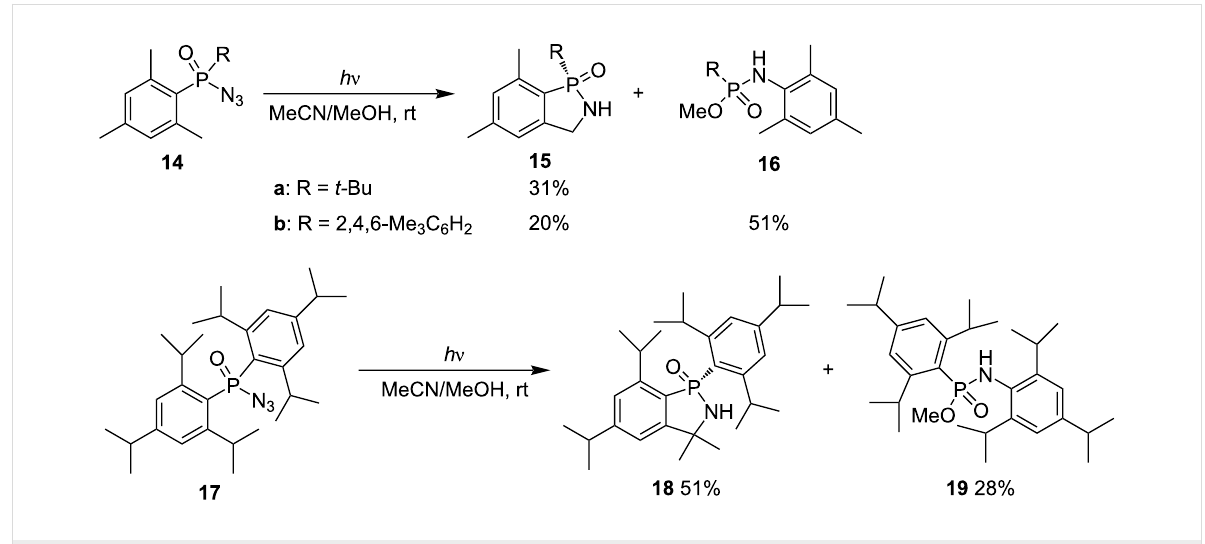
Scheme 4: Synthesis of 2,3-dihydrobenzo[ c ][1,2]azaphosphole 1-oxides from alkylarylphosphinyl or diarylphosphinyl azides via an intramolecular nitrene C–H insertion.